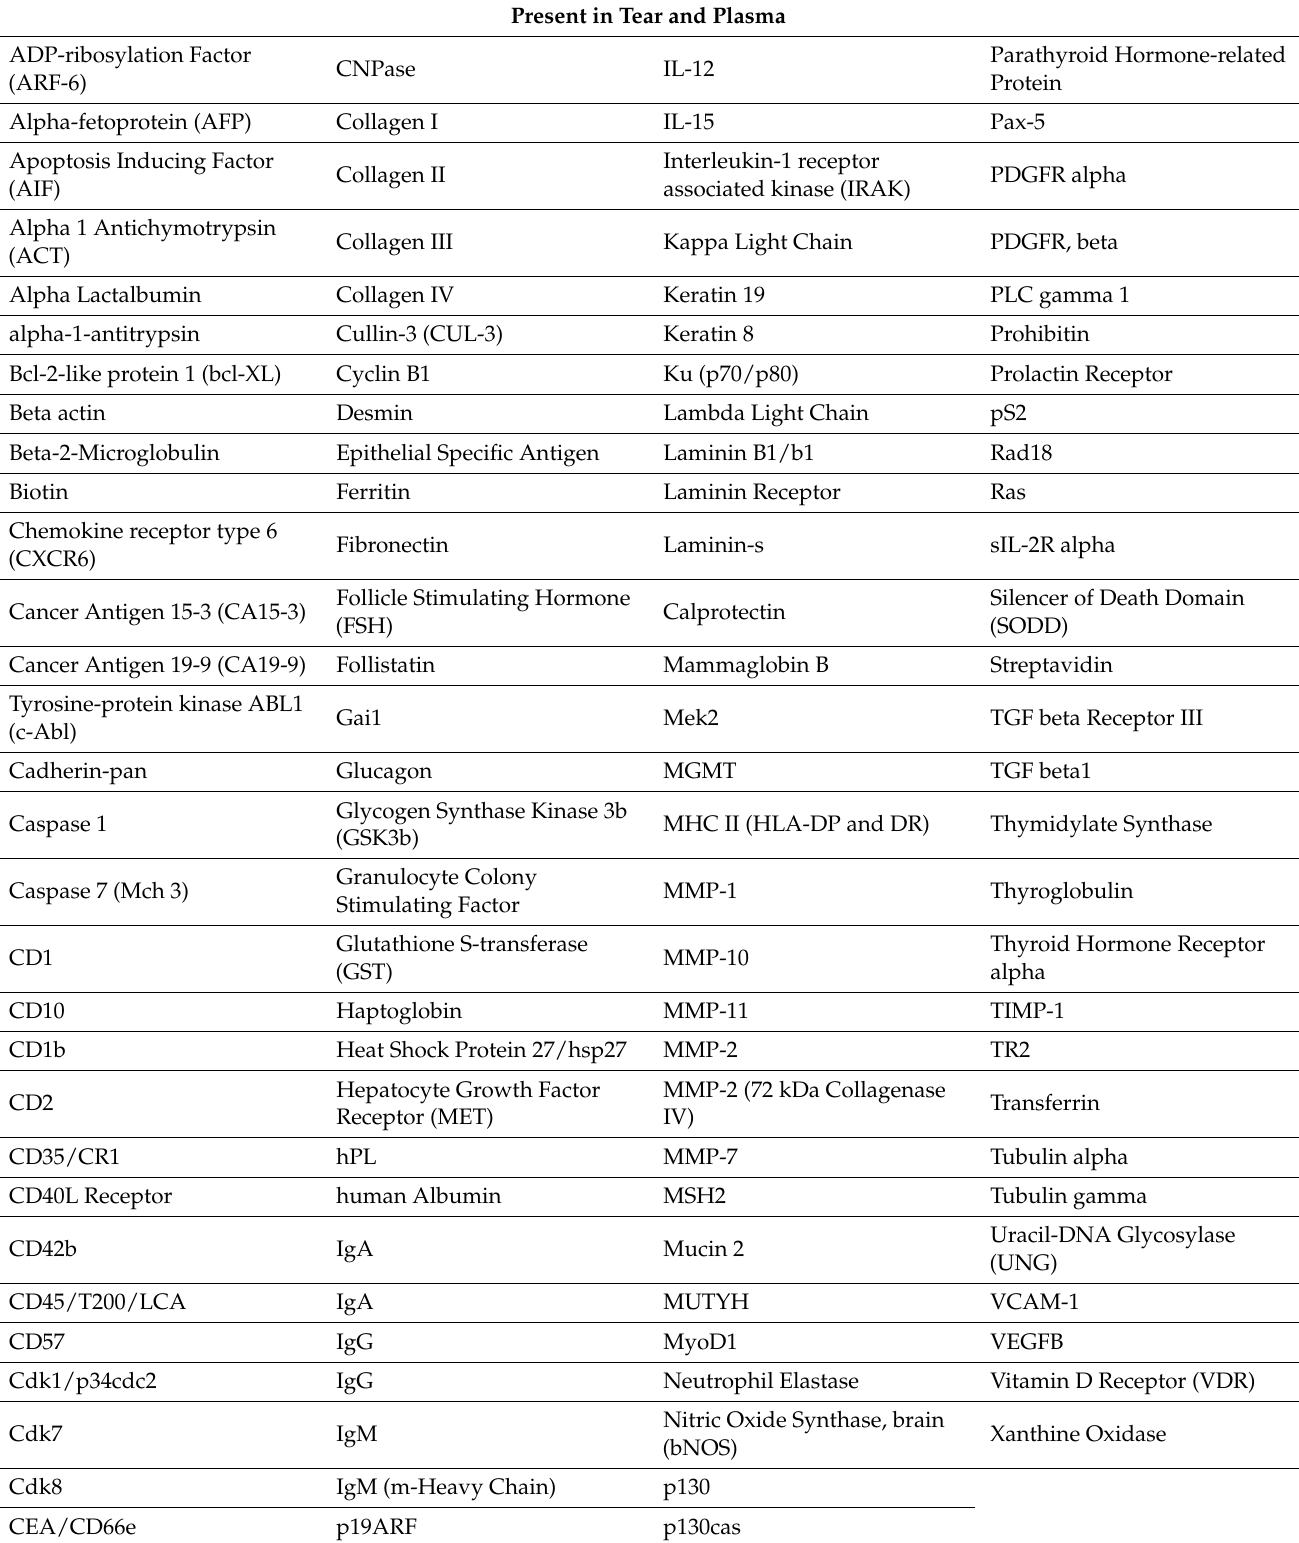
Table 1. List of common proteins detected via microarray in tears and plasma